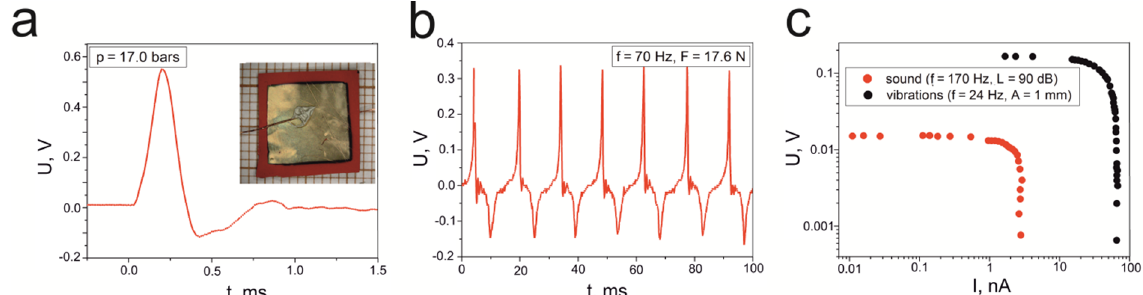
Figure 14. Graphs showing the output voltage from the epoxy resin/SbSI samples (S4), in which ( a ) the applied pressure is 17.0 bars and ( b ) the force impact is 17.6 N with a frequency of 70 Hz. ( c ) Graph depicting the output voltage of sample S4 against the current intensity, which are registered for different load resistances and various excitations. Here, the black spot represents an acoustic wave with a frequency of 70 Hz and a sound pressure level of 90 dB and the red spot denotes vibrations with an amplitude of 1 mm and a frequency of 24 Hz. The inset of ( a ) is a photograph of sample S4.